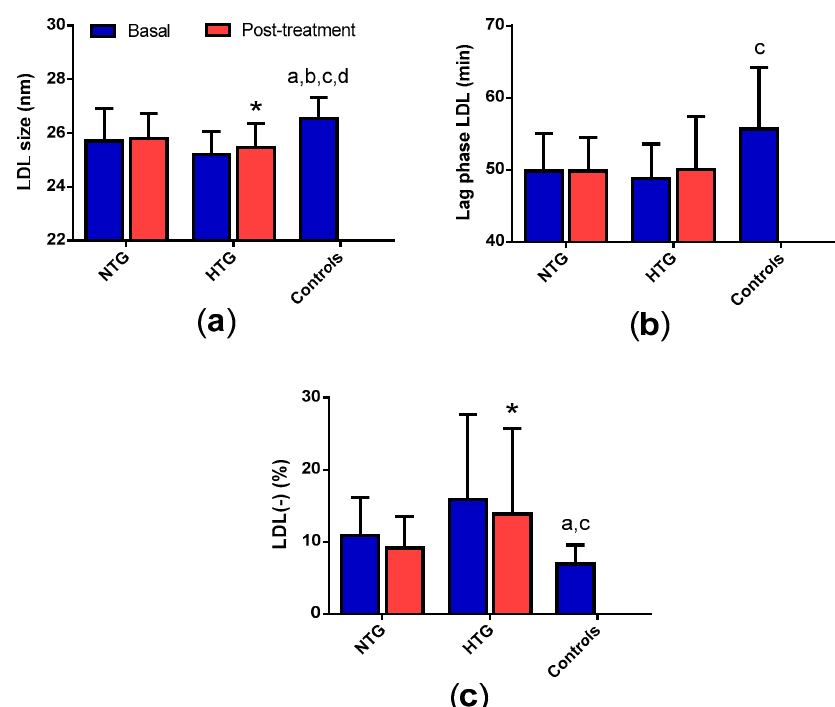
Figure 5. Qualitative properties of LDL. ( a ) LDL particle size was determined by gradient gel electrophoresis (GGE) and expressed as nm. ( b ) Lag phase time of the oxidation kinetics of LDL induced by CuSO 4 monitoring the formation of conjugated dienes, expressed as min. ( c ) Proportion of electronegative LDL. Data are expressed as mean ± SD. * p < 0.05 vs. basal samples. a p < 0.05 vs. basal NTG. b p < 0.05 vs. NTG post-treatment. c p < 0.05 vs. basal HTG. d p < 0.05 vs. HTG post-